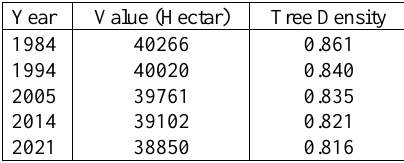
Table 1. Changes of trees in the study area from 1984 to 2021.